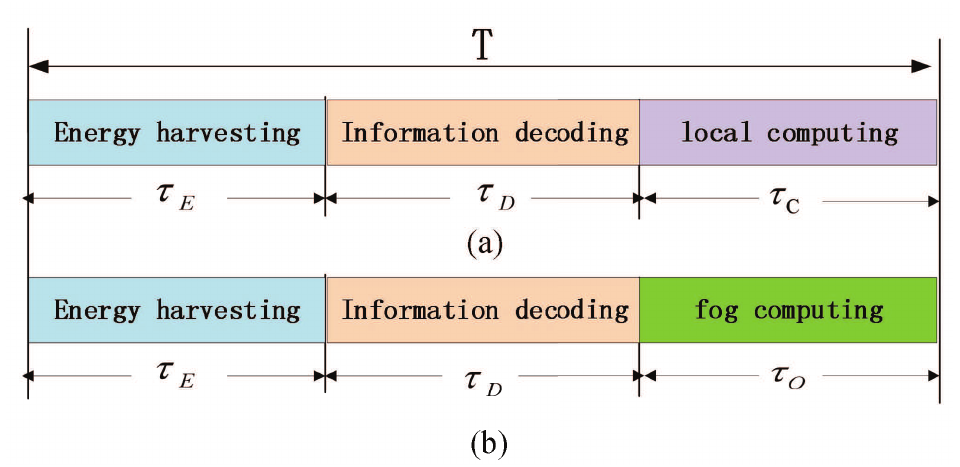
Figure 2. Time allocation frameworks: ( a ) local computing mode; and ( b ) fog computing